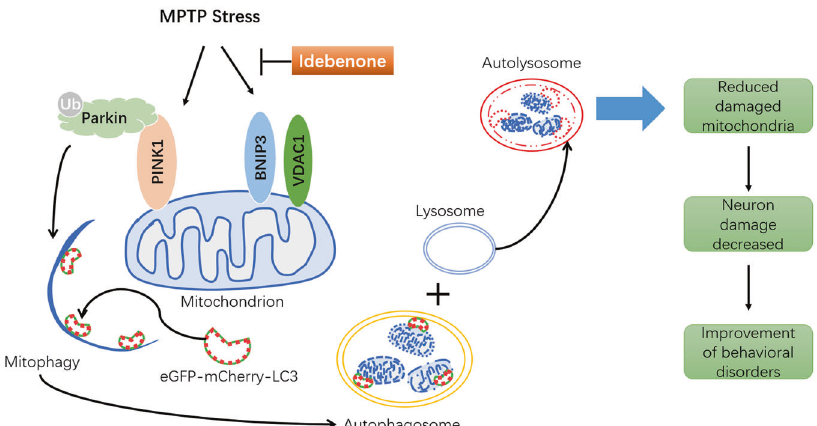
Fig. 6 The effect of idebenone on mitophagy in MPTP mice. Idebenone affects Parkin/PINK1-mediated mitophagy by regulating BNIP3 and VDAC1 in MPTP-induced subacute PD eGFP-mCherry-LC3